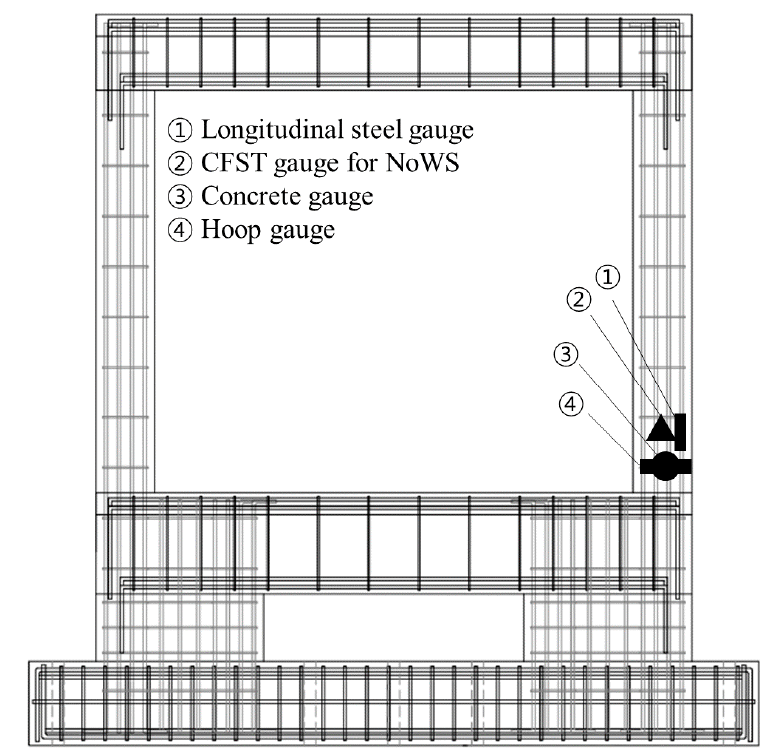
Figure 9. Location of